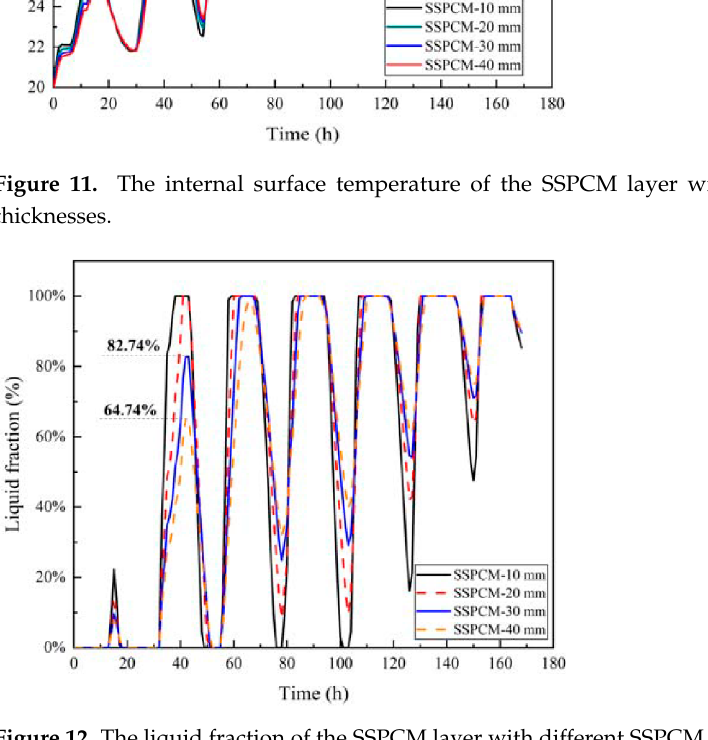
Figure 11. The internal surface temperature of the SSPCM layer with different SSPCM layer thick- nesses.